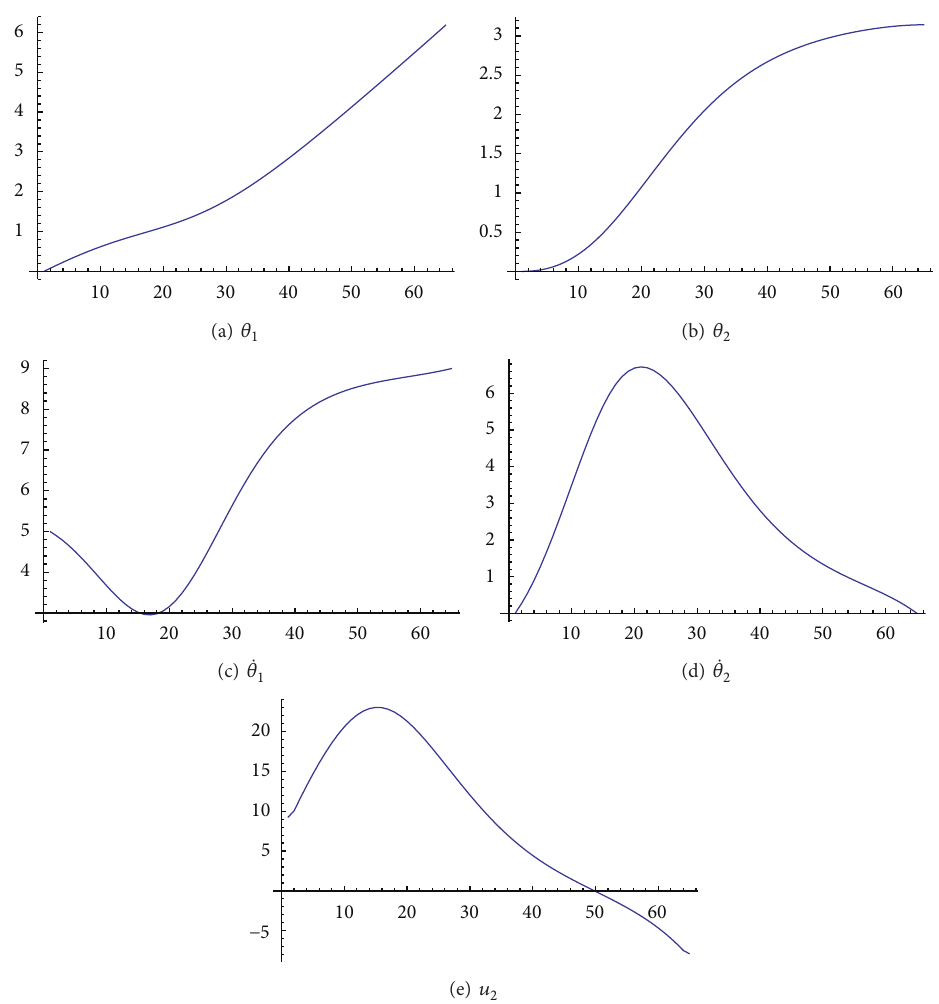
Figure 9: Control and state variables of the optimal solution of problem 4, an initial value problem for an underactuated 𝑅𝑅 planar robot manipulator with boundary conditions 𝜃 1 (𝑡 𝐼 ) = 0 [ rad ] , 𝜃 2 (𝑡 𝐼 ) = 0 [ rad ] , ̇𝜃 (𝑡 ) = free, and ̇𝜃 (𝑡 ) = 0 [ rad / s ] . The initial and final times are 𝑡 1 𝐹 2 𝐹 configurations of the robot manipulator at times 𝑘(1/32) with 𝑘 = 0, 1,. . . , 32 is represented in Figure